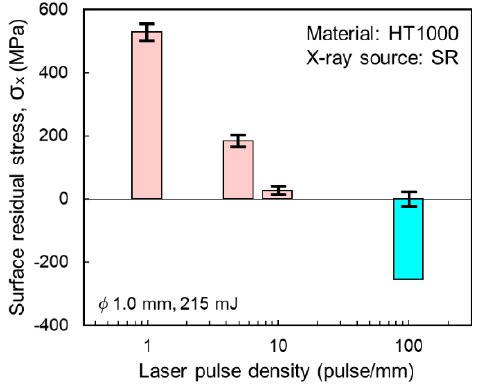
Figure 6. Surface RSs in the x-direction at the center of laser-irradiated lines.